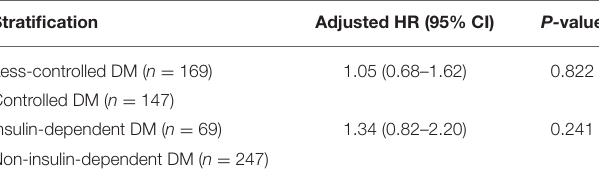
TABLE 5 | Stratification analysis on 5-year MACCE in the diabetes